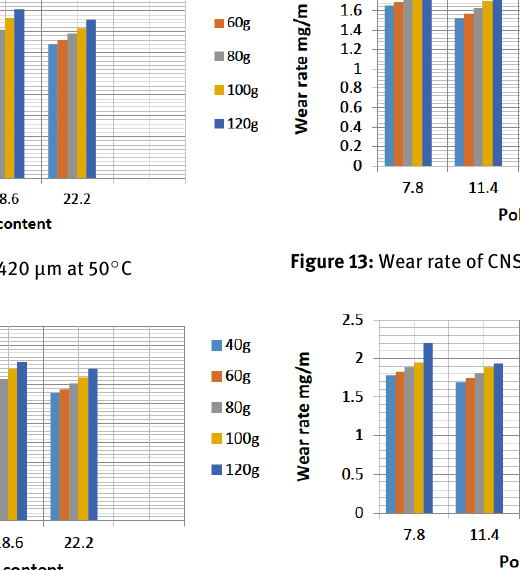
Figure 14: Wear rate of CNS /Polyester 420 µ m at 150 ∘